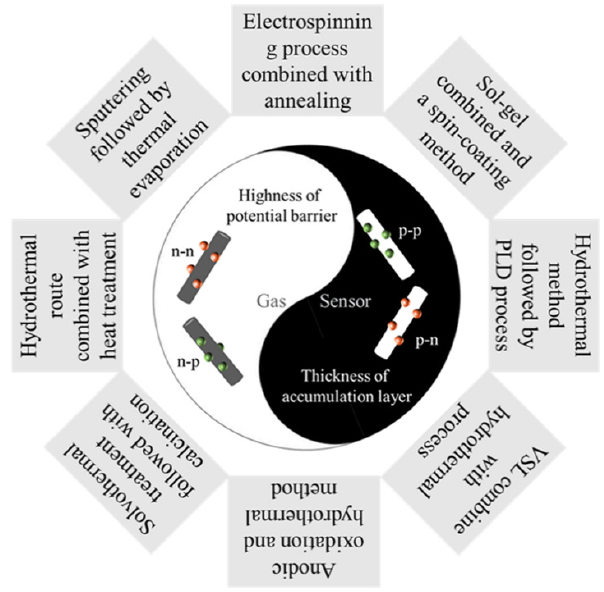
Figure 2. Typical types of heterojunctions for high-performance gas sensors and assembly strategies.